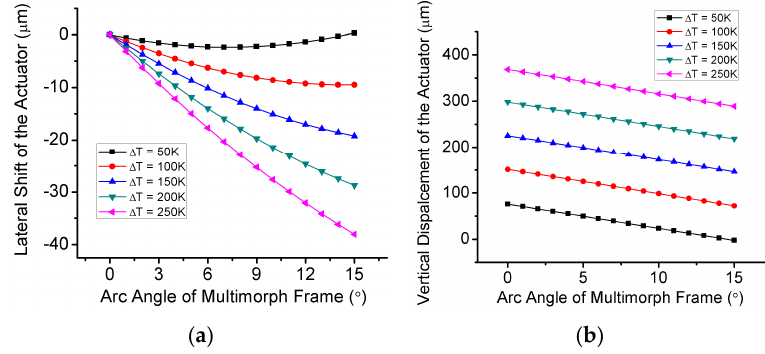
Figure 5. Calculation results of ( a ) maximum lateral shift and ( b ) vertical displacement versus the arc angle of the multimorph frame γ at different average temperature changes of the bimorphs I/II/III.